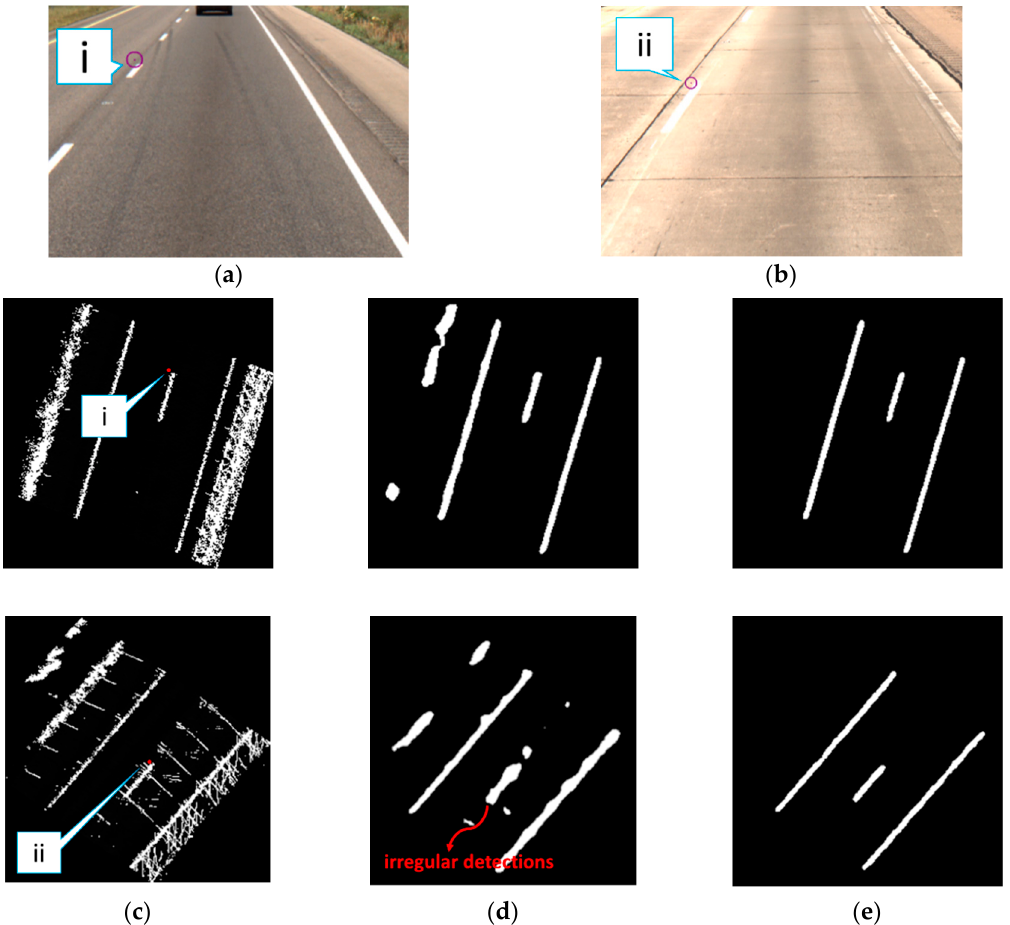
Figure 21. RGB imagery of ( a ) location i and ( b ) location ii and illustrations of ( c ) original intensity images, and images with predicted lane markings from ( d ) U-net model 1 and ( e ) U-net model 2 in dataset 2.